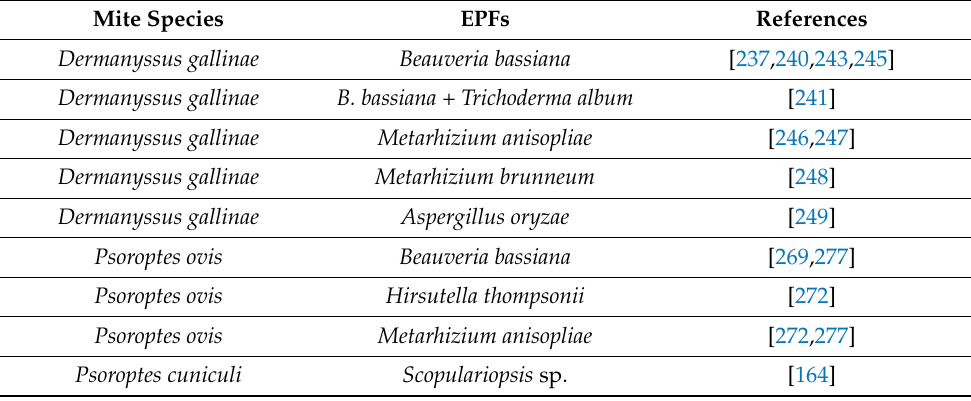
Table 2. Entomopathogenic fungi (EPFs) active versus different mite